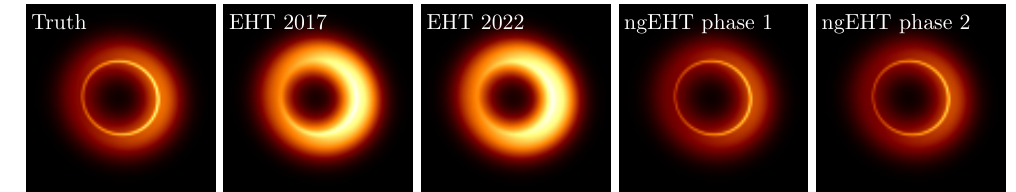
Figure 2. Results from self-fits of geometric models to synthetic data for a series of EHT and ngEHT arrays. Each fit includes two m-ring components, as described in Section 2.1. The left panel shows the ground truth model; the remaining panels show the mean image for the array noted at the top. Even for this optimistic test, the EHT coverage is insufficient to identify the n = 1 photon ring. However, the longer baselines of the ngEHT allow clear detection of the n = 1 photon ring.